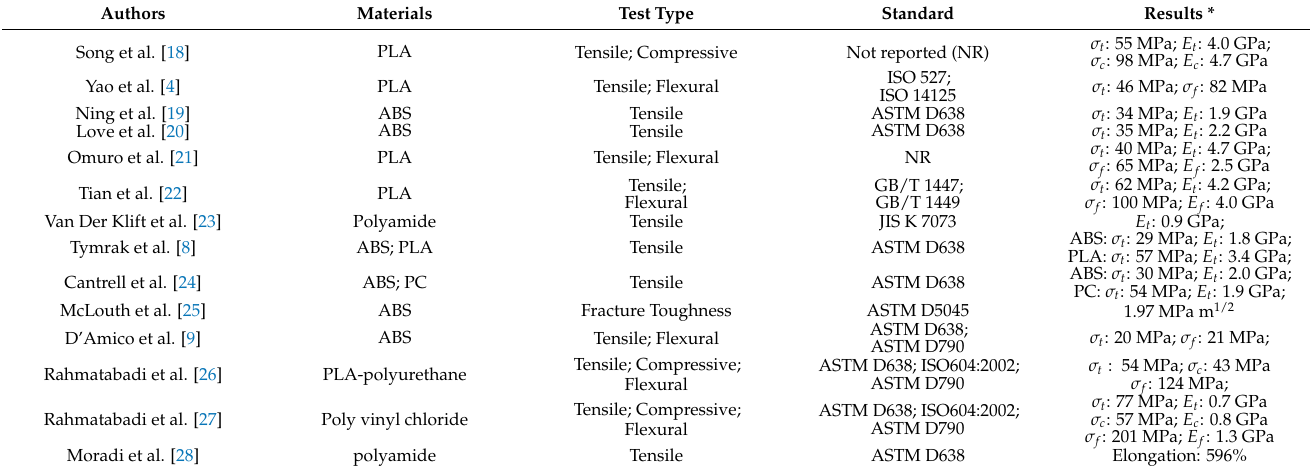
Table 1. The mechanical properties of ME-printed thermoplastic polymer reported in the literature.